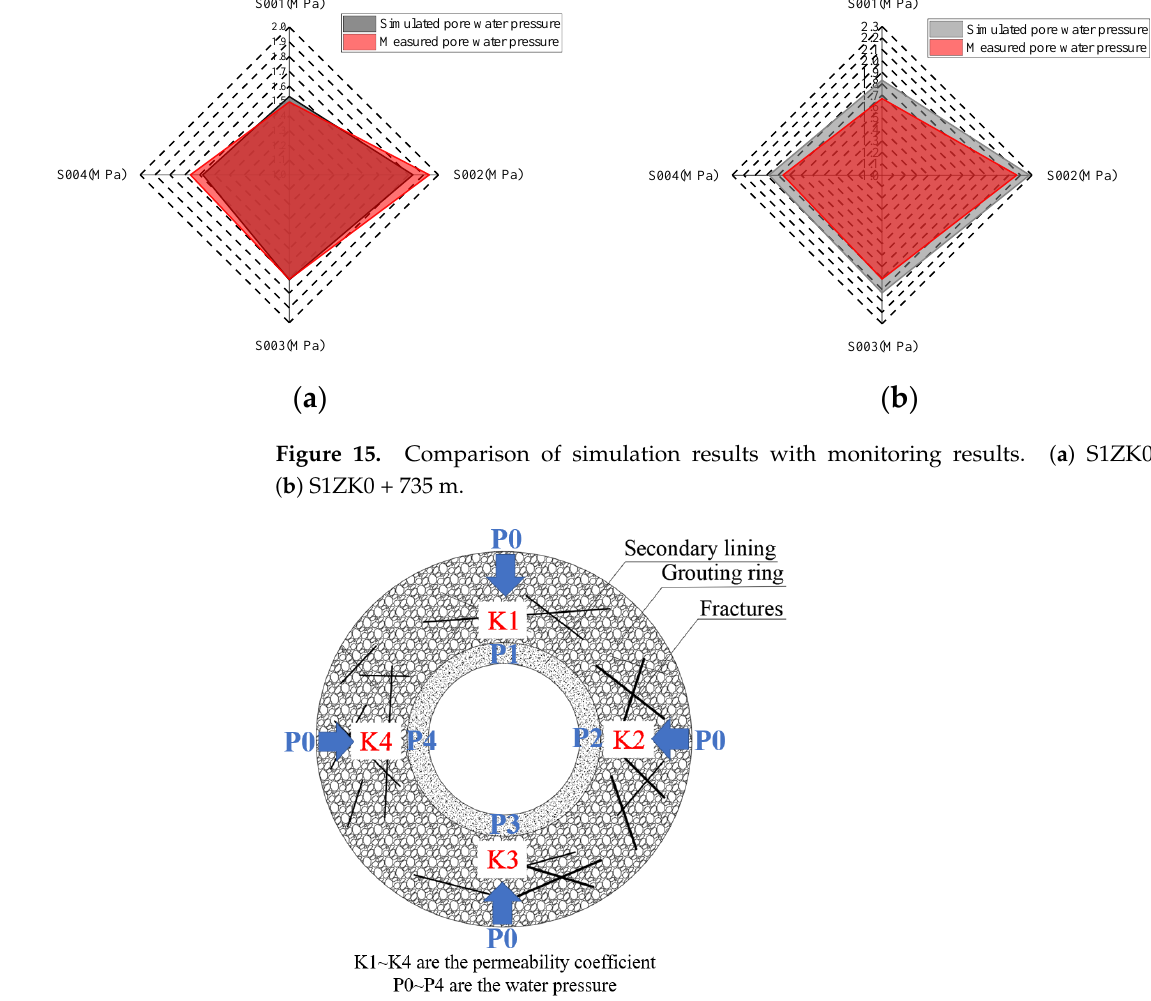
Figure 16. Description of the principle of water pressure characteristics.